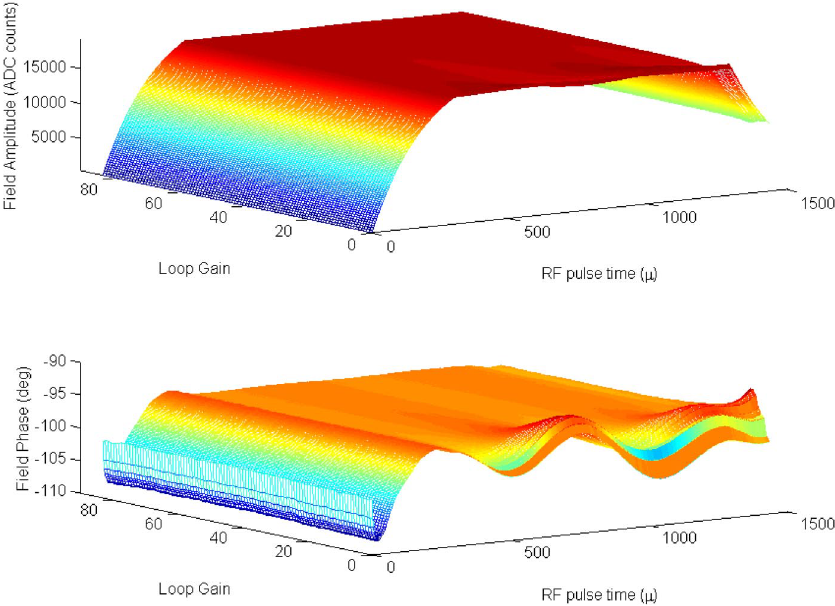
FIG. 11. (Color) The ripples of the mechanical mode on the cavity field amplitude and phase are largely damped out as the loop gain of the feedback control reaches sufficiently high. In this measurement, the value of the loop gain is varied from zero (i.e. no feedback control) to 83 over 100 rf